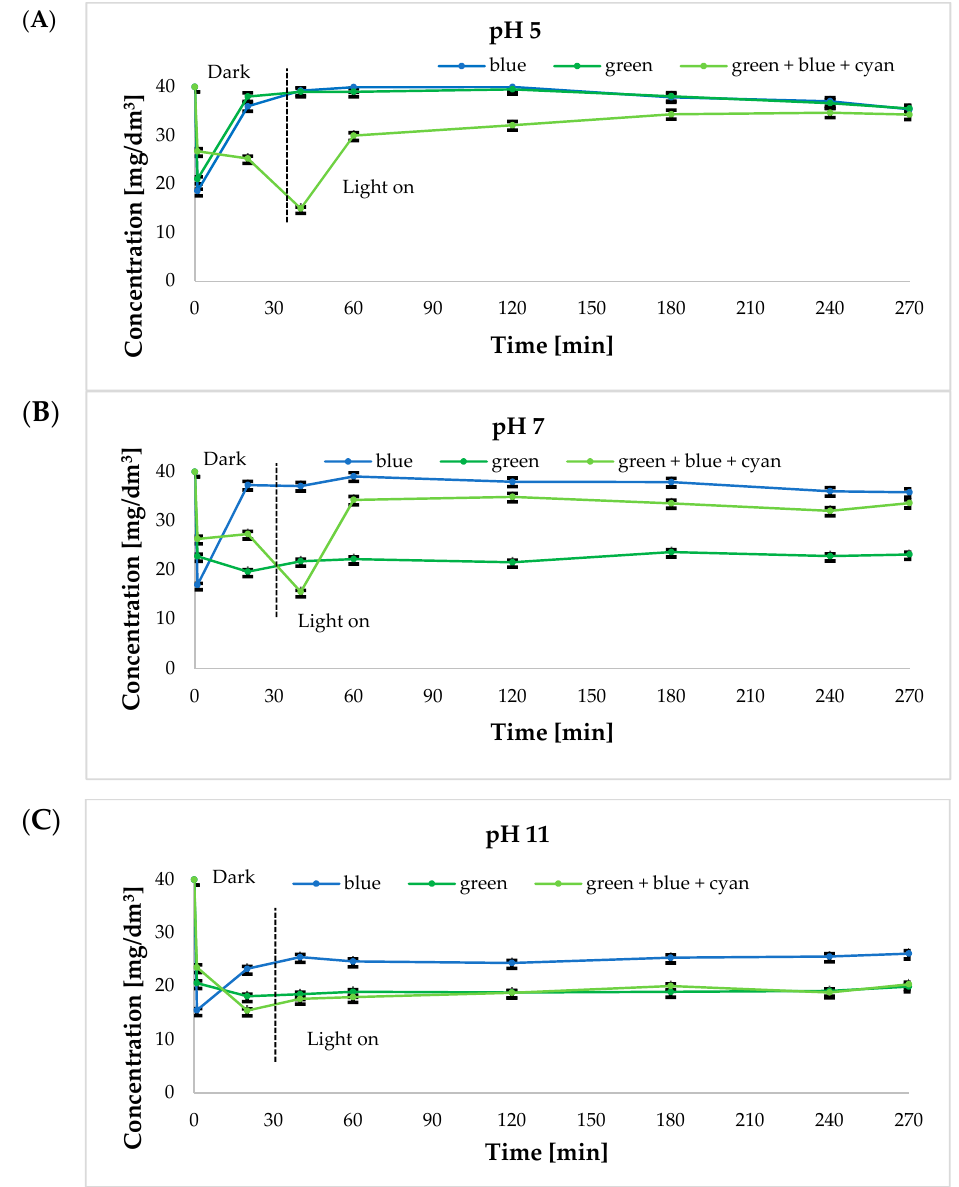
Figure 5. Time dependence of absorbance for 40 mg/dm 3 bisphenol A solutions under green, blue, and green+blue+cyan light irradiation at 65 ◦ C at different solution pH values using ruthenium ion-modified biosilica; ( A ) pH 5; ( B ) pH 7; ( C ) pH 11. The initial concentration of BPA was 40 mg/dm 3 .